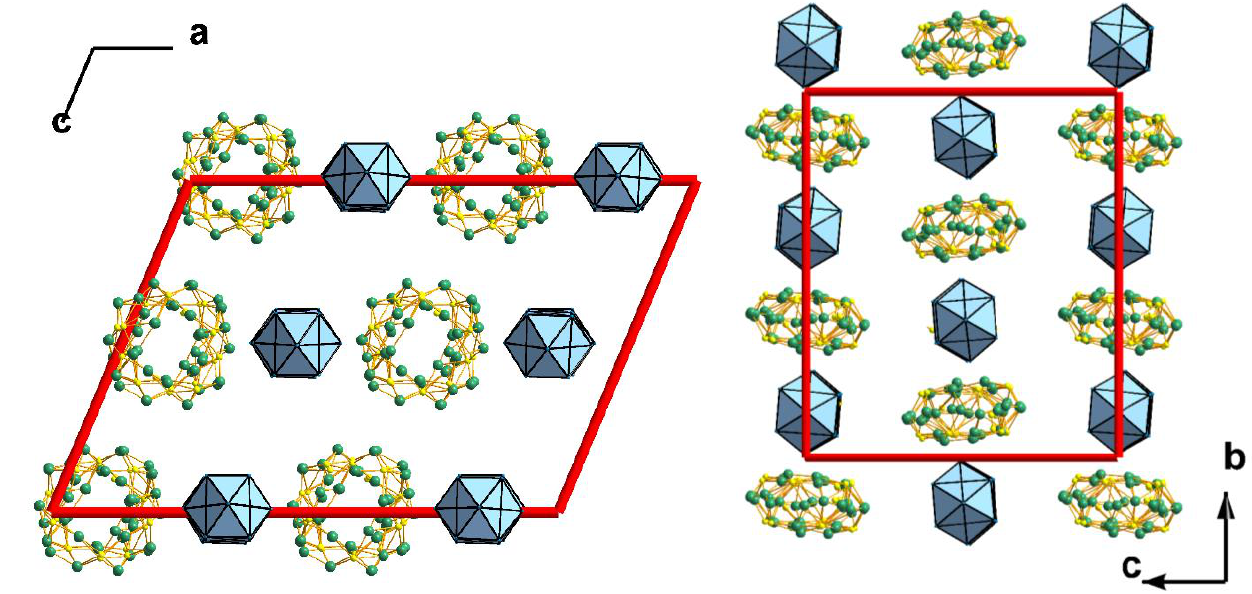
Figure 2. Crystal packing of 2 . Disordered NO 3 − , oxoligands, and DMSO molecules are omitted for clarity. [SiW 12 O 40 ] 4– anions are presented as 4olyhedra .